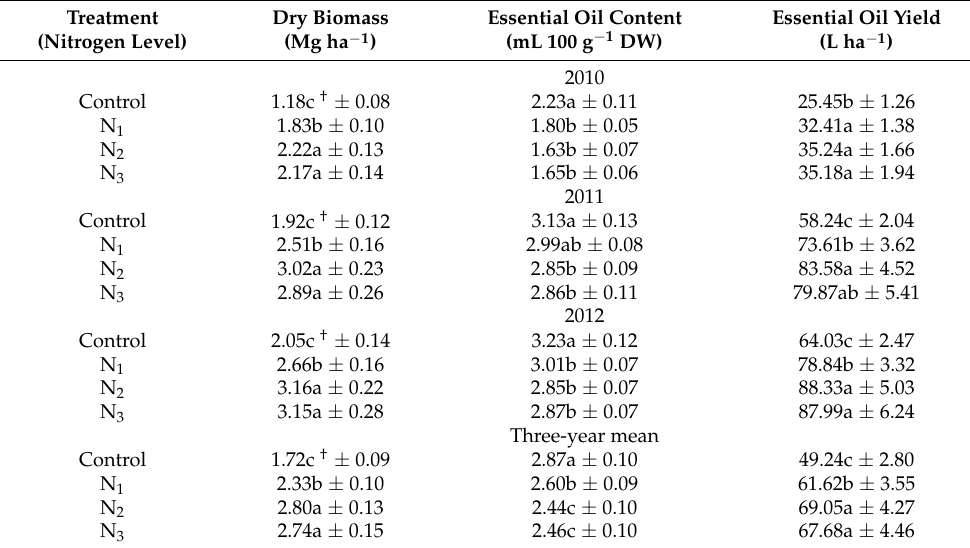
Table 2. The effect of different nitrogen fertilization levels (control, N1, N2, N3, that correspond to 0, 40, 80 and 120 kg N ha − 1 , respectively) on the mean dry biomass production (Mg ha − 1 ), essential oil content (mL 100 g − 1 DW) and essential oil yield (L ha − 1 ) of all of the five Greek oregano populations combined (1-Panagia, 2-Litochoro, 3-Omolio, 4-Papadates, 5-Vytina), for each cultivation year and averaged for the three-year